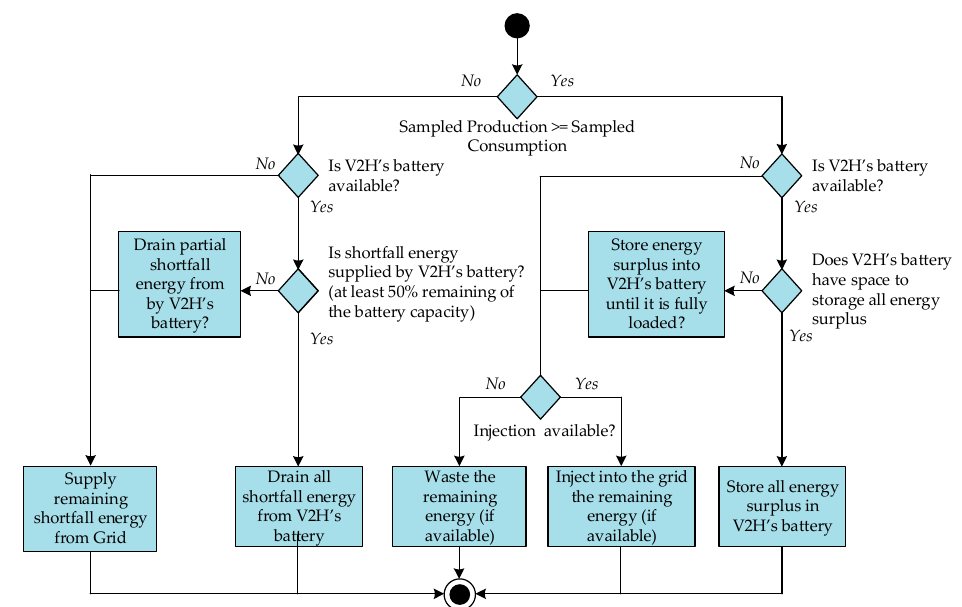
Figure 6. Activity decision diagram for every 15 min sampled energy.